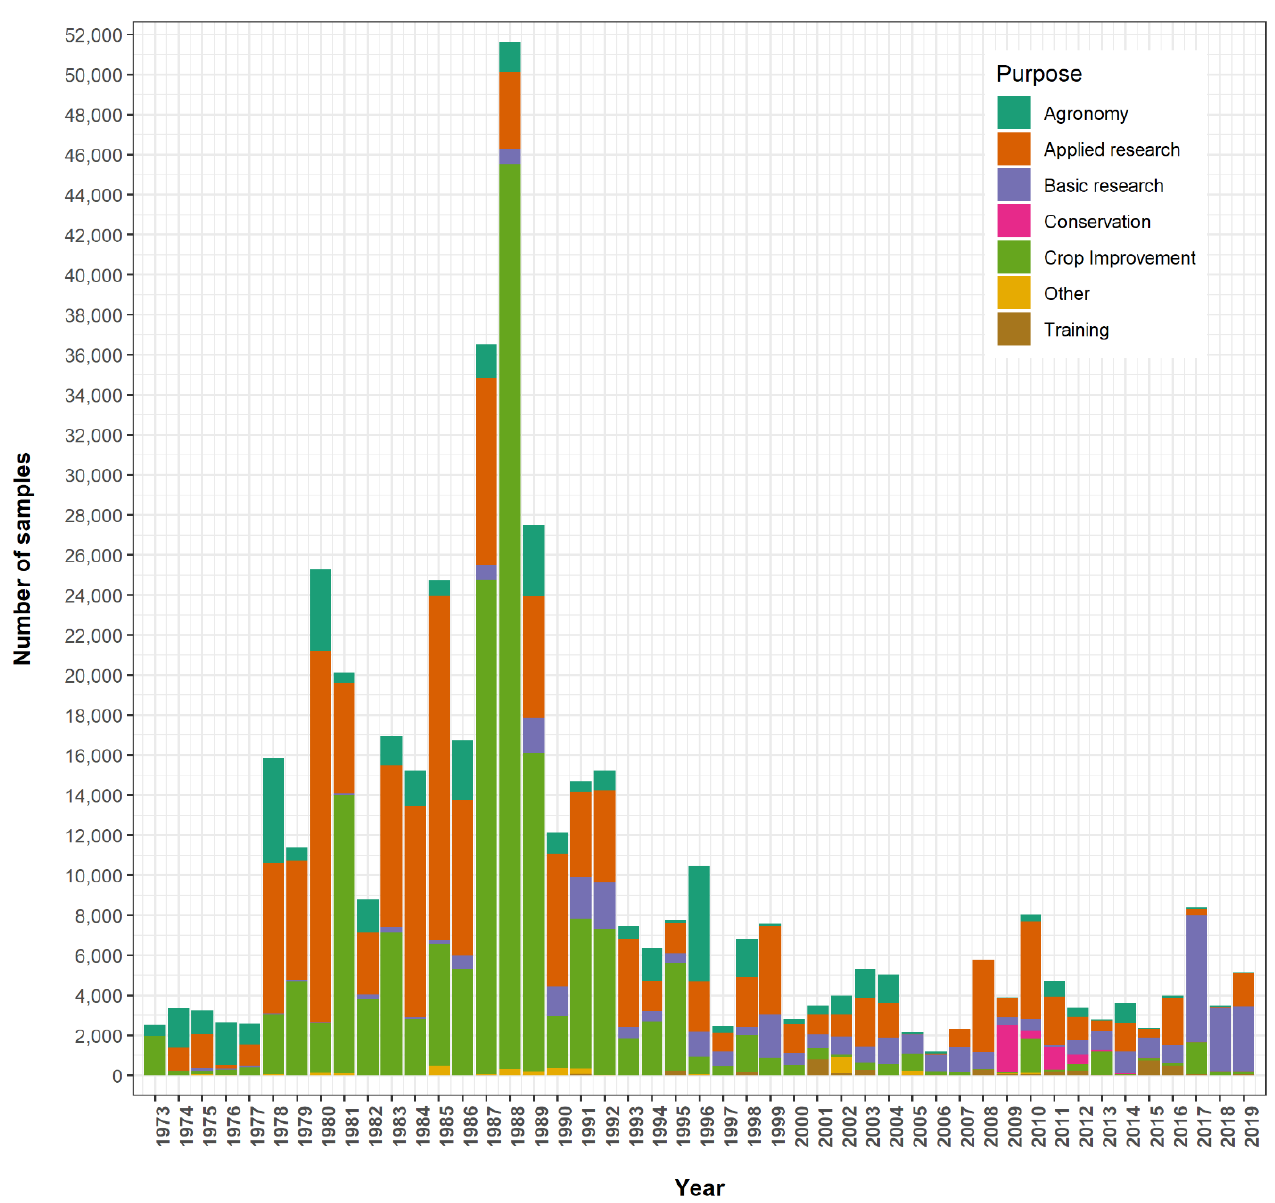
Figure 4. Number of samples distributed annually to users in the period 1973-2019, according to the purposes of requests.